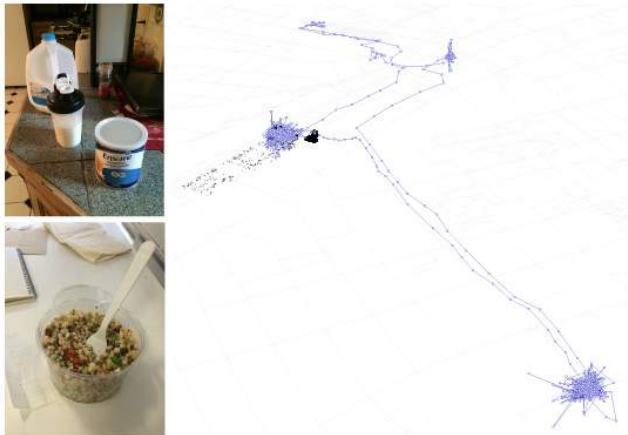
Figure 8 : Images typical of Josh’s eating and a map showing his four primary points. The two foreground points are home and school, the other less intense points are food purchase locations. The tracks form a continuous loop, with no redundancies, indicating value placed on